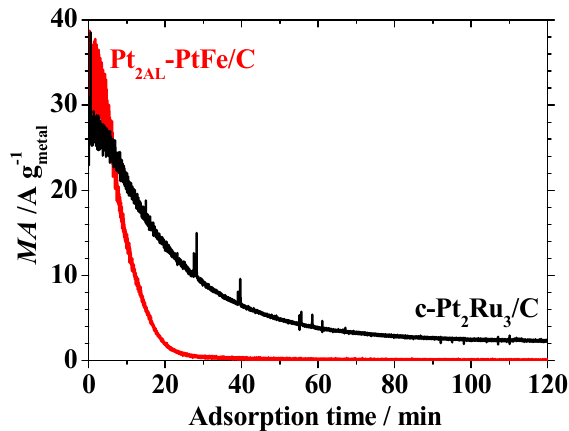
Figure 2. Change in the mass activity ( MA ) for the HOR at 0.02 V on Nafion ‐ coated Pt 2AL –PtFe/C and c ‐ Pt 2 Ru 3 /C electrodes at 0.02 V and 60° C in 0.1 M HClO 4 during CO adsorption by bubbling 1% CO/H 2 .